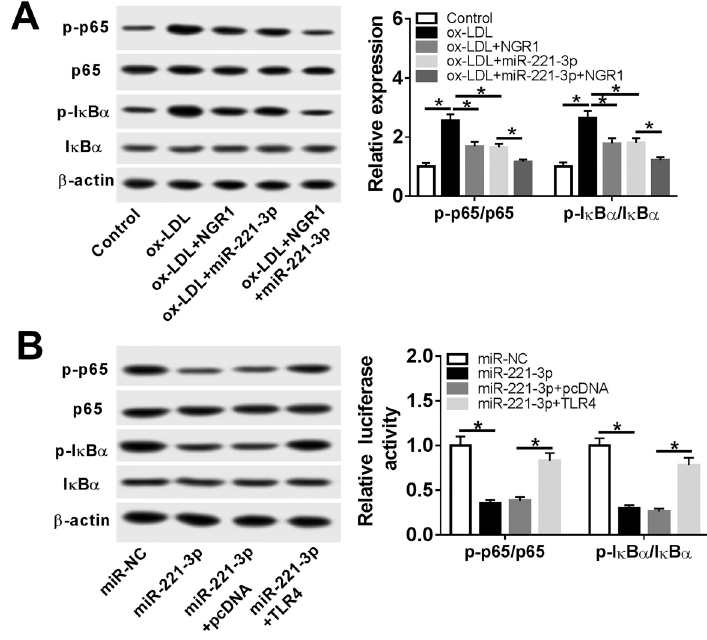
Figure 5. NGR1 inactivated the TLR4/NF- k B pathway in oxidized low-density lipoprotein (ox-LDL)-treated induced human umbilical vein endothelial cells (HUVECs) through miR-221-3p. A , HUVECs were transfected with miR-221-3p mimic or miR-NC (negative control), followed by treatment with 50 mg/L ox-LDL or 30 m mol/L NGR1. Western blot analysis was performed to detect the protein levels of p-p65, p65, p-I k B a , and I k B a in HUVECs. B , HUVECs were transfected with miR-221-3p mimic, miR-NC, miR-221-3p mimic + pcDNA, or miR-221-3p mimic + TLR4 followed by treatment with 50 mg/L ox-LDL. The protein levels of p-p65, p65, p-I k B a , and I k B a were analyzed by western blot analysis. Data are reported as means ± SD from three independent experiments. *P o 0.05